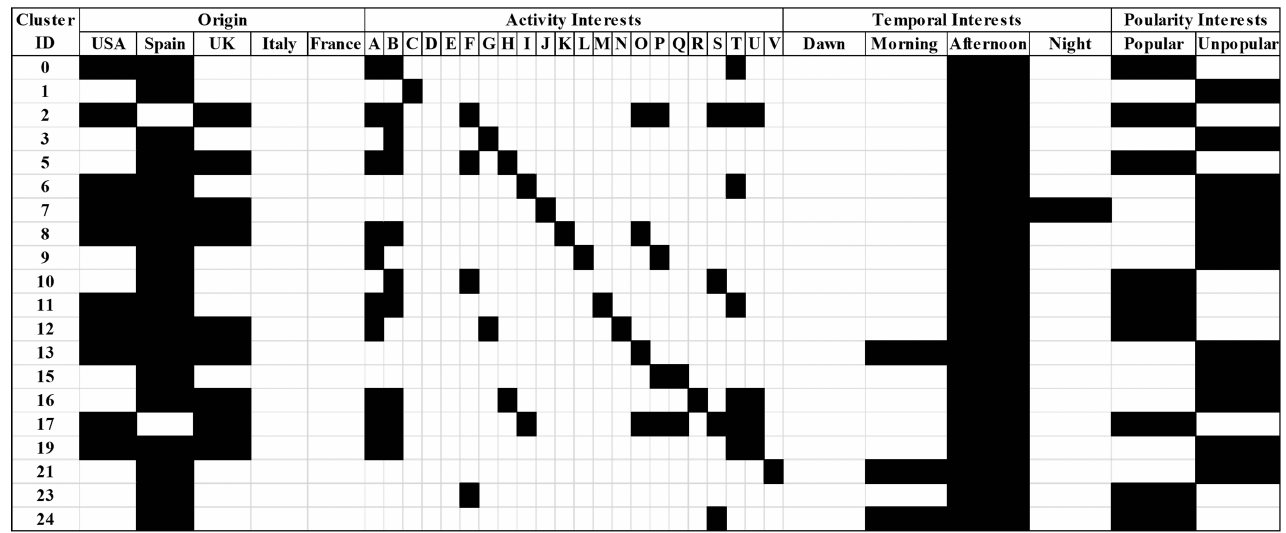
Figure 1. Cluster characteristics highlighting tourists’ origin, preferred tour time, orientation towards